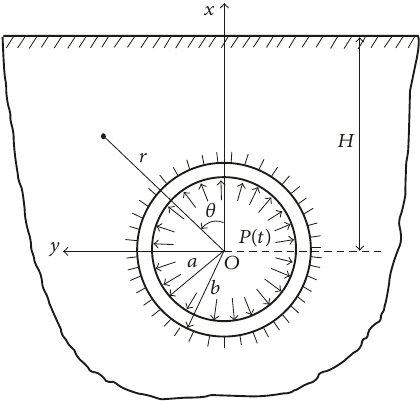
Figure 1: Circular tunnel embedded in a half